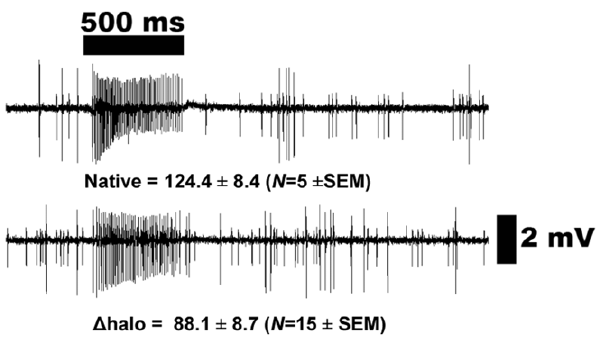
Figure 9. Comparative responses of Or42a expressed in its native environment and in the ‘‘empty neuron.’’ Ethyl butyrate (source dose, 10 m g) elicited higher responses from pb1 sensilla of wild type flies (top trace) than from the ab3 sensilla of Or42a-expressing flies (w; D halo; UAS-DmOr42a/Or22a-GAL4) (lower trace). SEM, standard error of the